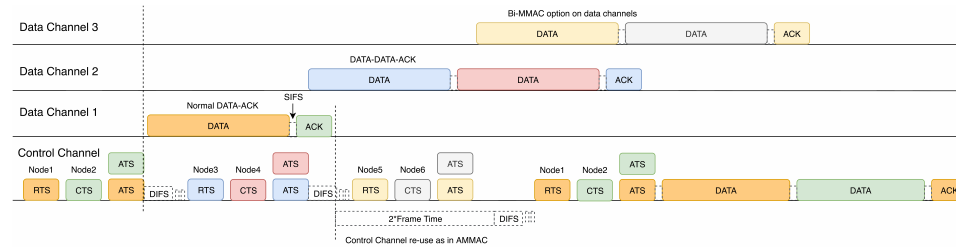
Figure 1. Timing diagram for proposed MMAC protocol.